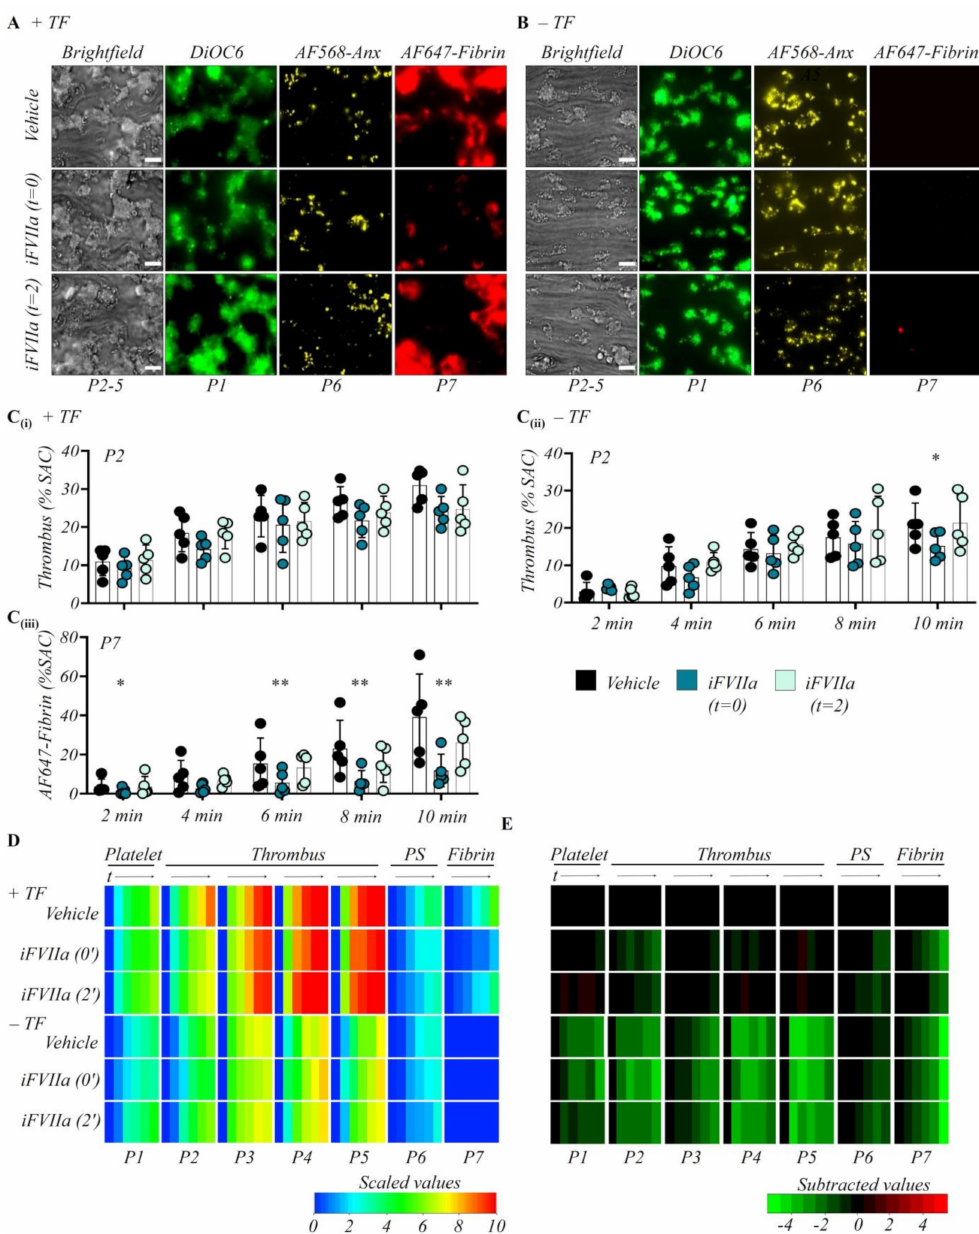
Figure 1. Early contributions of TF and factor VIIa in whole-blood thrombus formation. Citrated whole blood samples from healthy subjects ( n = 5) were supplemented with fluorescent labels to simultaneously detect platelet adhesion (P1, DiOC 6 ), thrombus and platelet multilayer characteristics (P2–5, brightfield), phosphatidylserine exposure (P6, AF568-annexin A5), and fibrin deposition (P7, AF647-fibrin). Using a three-way tubing inlet system, allowing complete fluid mixing, we co-infused blood samples with recalcification medium and perfused them through a parallel-plate flow chamber containing microspots of collagen (upstream) and collagen/TF (downstream) at a wall-shear rate